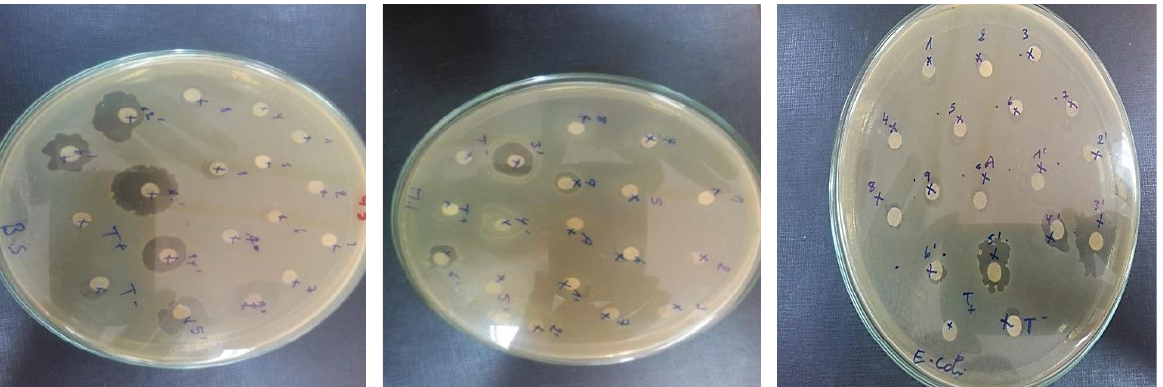
Figure 8. Sensitivity test in agar